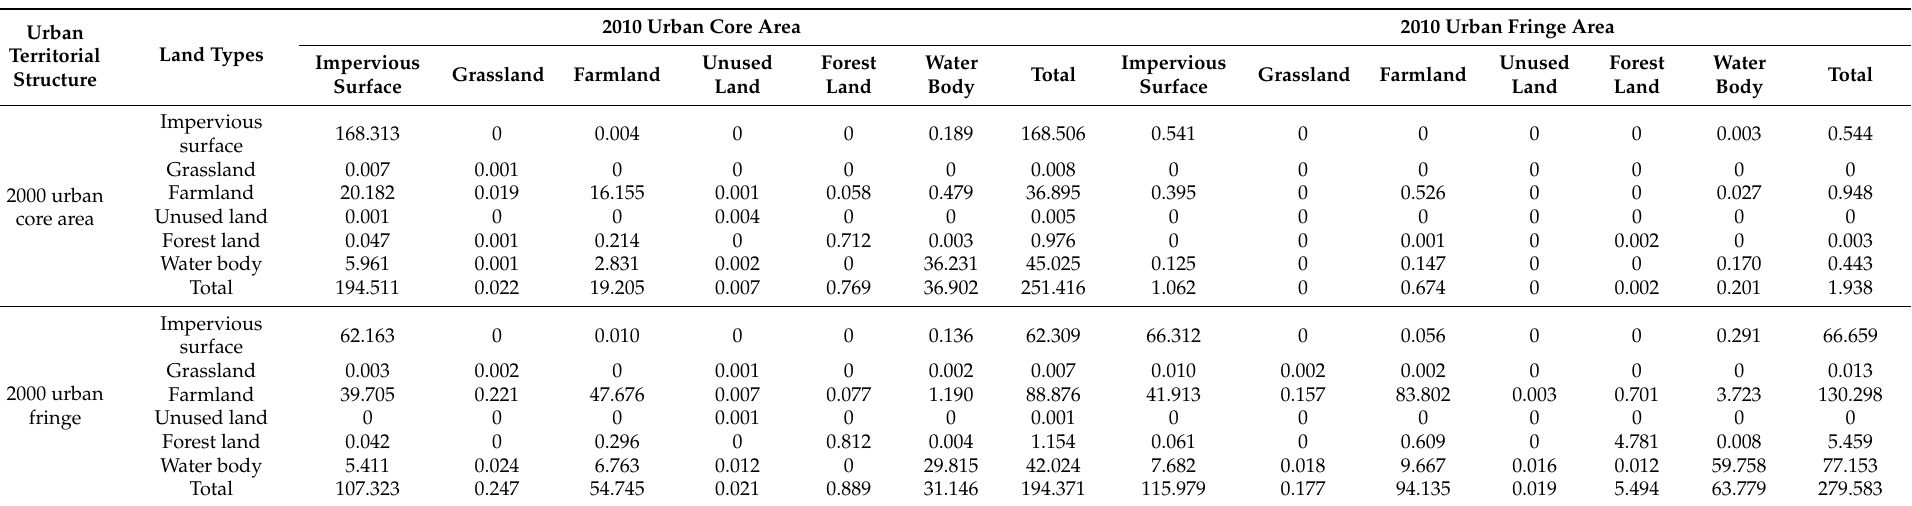
Table A1. Wuhan Land Use Transfer Matrix of urban core area and urban fringe, 2000–2010.